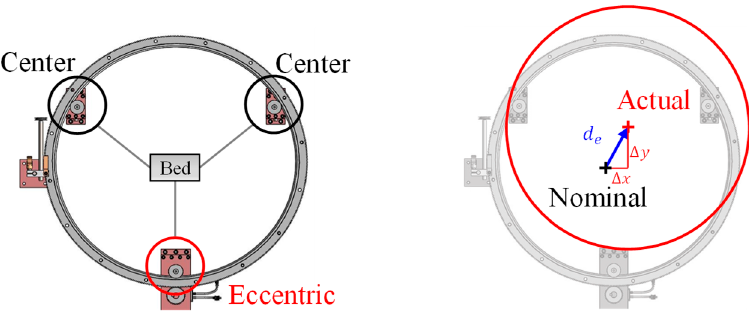
Figure 5. The center alignment error is caused by the eccentric bearing of the circular Figure 5. the center alignment error is caused by the eccentric bearing of the circular slide.